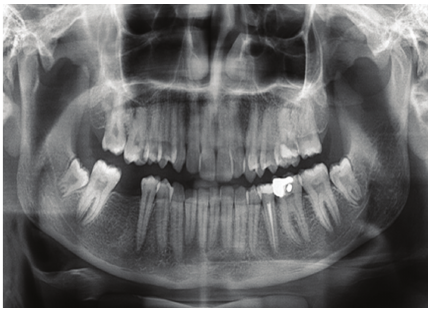
Figure 5: Follow-up panoramic radiograph taken after 1 year. Periapical lesion of mandibular second premolar is completely dis-